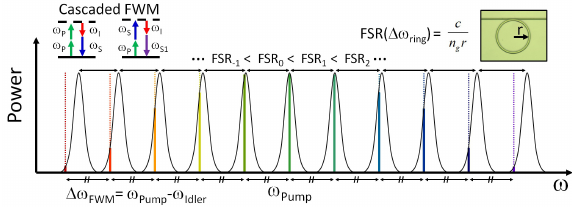
Figure 3: Phase mismatching in four wave mixing due to dispersion. The FSRs of the micro-ring resonator depend on the group index (n g ) of AlN which has dispersion in frequency domain, while the frequency gaps of FWM ( ∆ w FWM ) are all equal. The dispersion of AlN induces mismatch between the FWM (colored lines) and resonance peaks (black curves) that limits the comb eflciency and bandwidth. The top-right inset shows the top view of an AlN micro-ring. AlN: aluminum nitride; FWM: four-wave mixing.